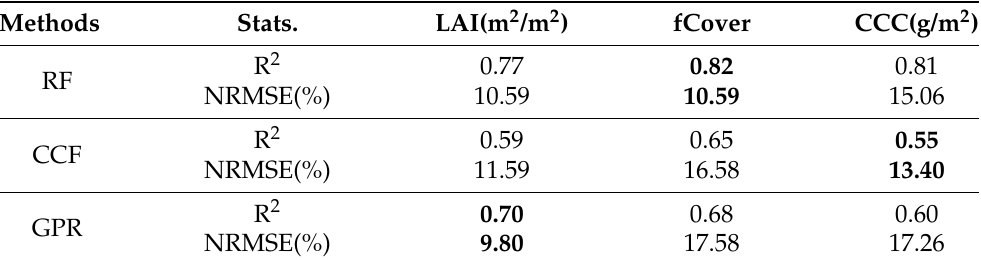
Table 5. Accuracy assessment between hybrid method-based ML approaches for the whole growth season.